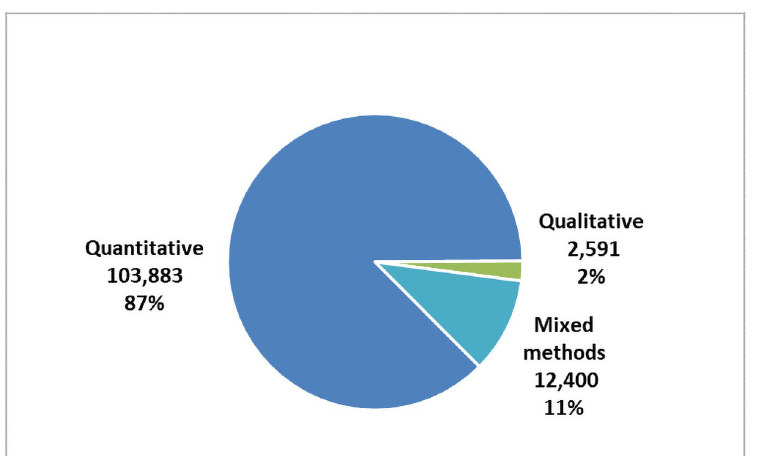
Fig 3. Number of participants by research